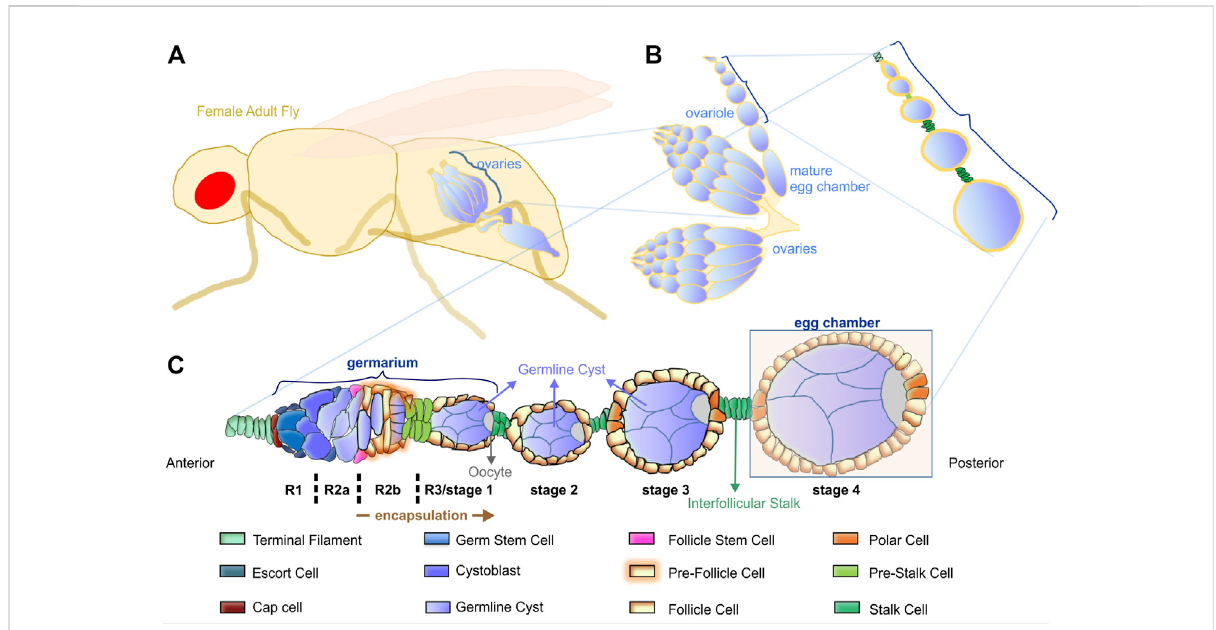
FIGURE 1 Overview of Drosophila oogenesis. (A) The female adult fl y has a pair of ovaries. (B) Each ovary comprises 16 – 20 ovarioles that contain linearly arranged egg chambers of increasing age. (C) Schematic representation of the cellular organization of the germarium and the consecutive egg chambers. The germarium is located at the anterior tip, where germ cells continuously divide and initiate oogenesis. The germarium is subdivided into four distinct morphological regions (R1, R2a, R2b, R3/stage1). At the posterior tip of the germarium, the pre-follicle cells complete the encapsulation of each cyst and form the egg chamber. An interfollicular stalk separates the egg chambers of different developmental